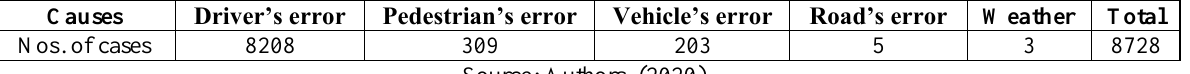
Table 17: Cases with respect to Causes of Road Accidents (1/2019~6/2019).